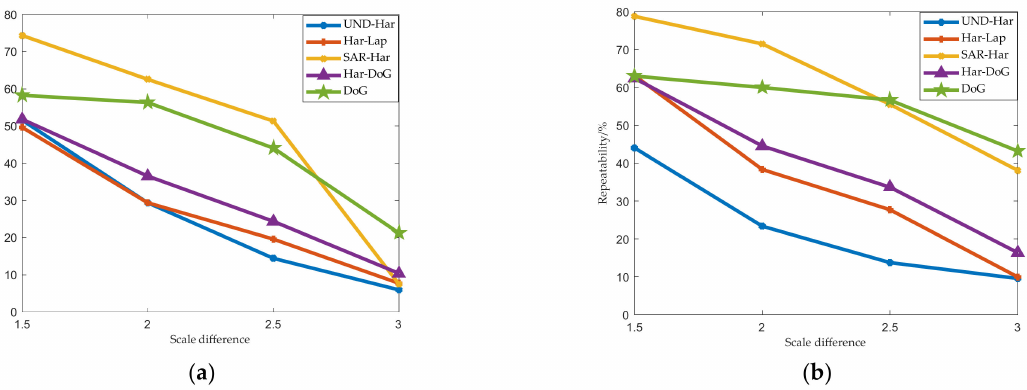
Figure 8. The effect of scale difference on repeatability: ( a ) Airborne SAR images. ( b ) Spaceborne SAR images.